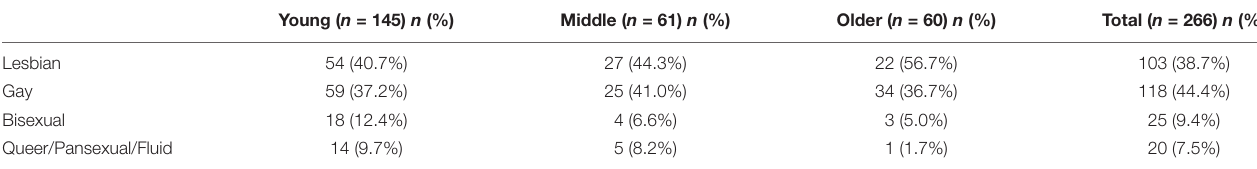
TABLE 1 | Rates of sexual orientation labels in young, middle, and older LGBQ+ adults. Young ( n = 145) n (%) Middle ( n = 61) n